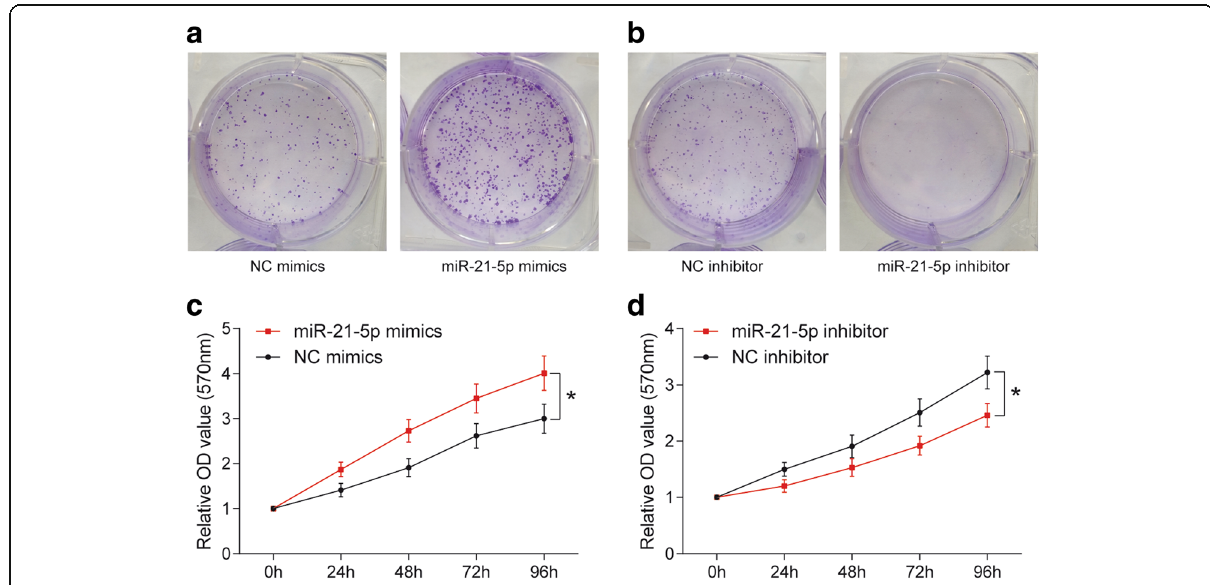
Fig. 3 MiR-21-5p promoted COAD cell proliferation. a , b According to the results of colony formation assay and MTT assay, colony cells in miR-21-5p mimics group were more than that in NC mimics group since 48 h transfection. * P <0.05, compared with NC mimics. c , d Colony cells in miR-21-5p inhibitor group were less than that in NC inhibitor group. * P <0.05, compared with NC inhibitor